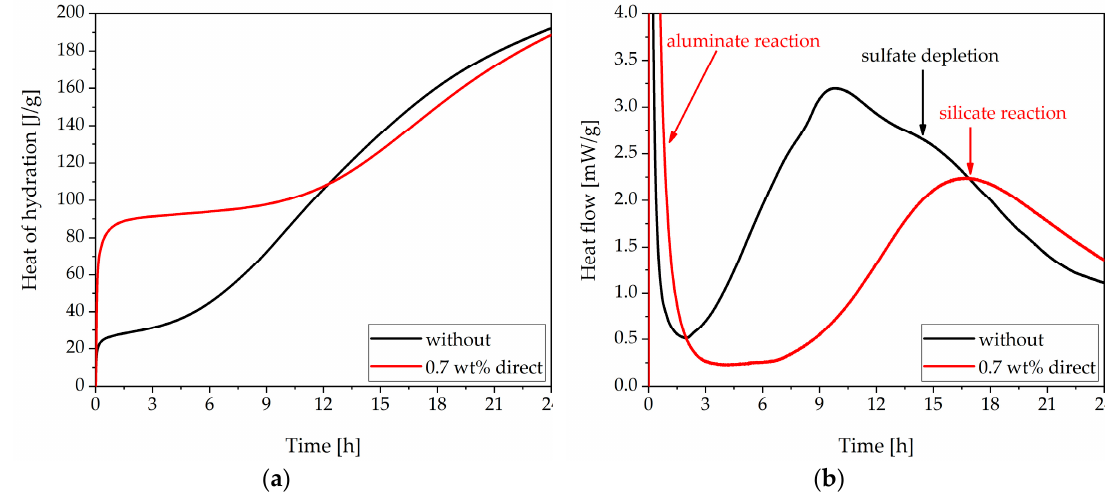
Figure 5. Calorimetric results of CEM I without superplasticizer (SP) and with direct addition of 0.7 wt% of SP (w/c = 0.36): ( a ) Heat of hydration and ( b ) Heat flow .